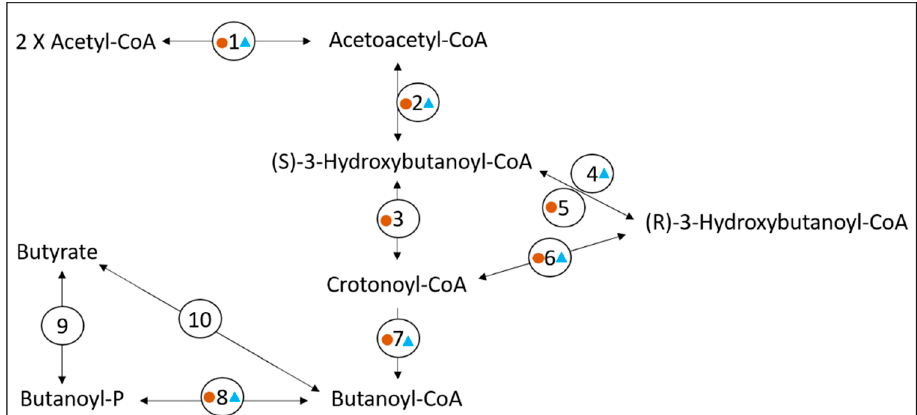
Figure 3. Proposed butyrate synthesis pathway for Bt-01708_Bf and Bt-01899_Ap. Coding sequences for enzymes identified in the Bt-01708_Bf contig set are labeled with a brown circle, while coding se- quences for enzymes identified in the Bt-01899_Ap contig set are labeled with a blue triangle. Key for enzyme legend: (1) acetyl-CoA C-acetyltransferase (EC 2.3.1.9); (2) 3-hydroxybutyryl-CoA